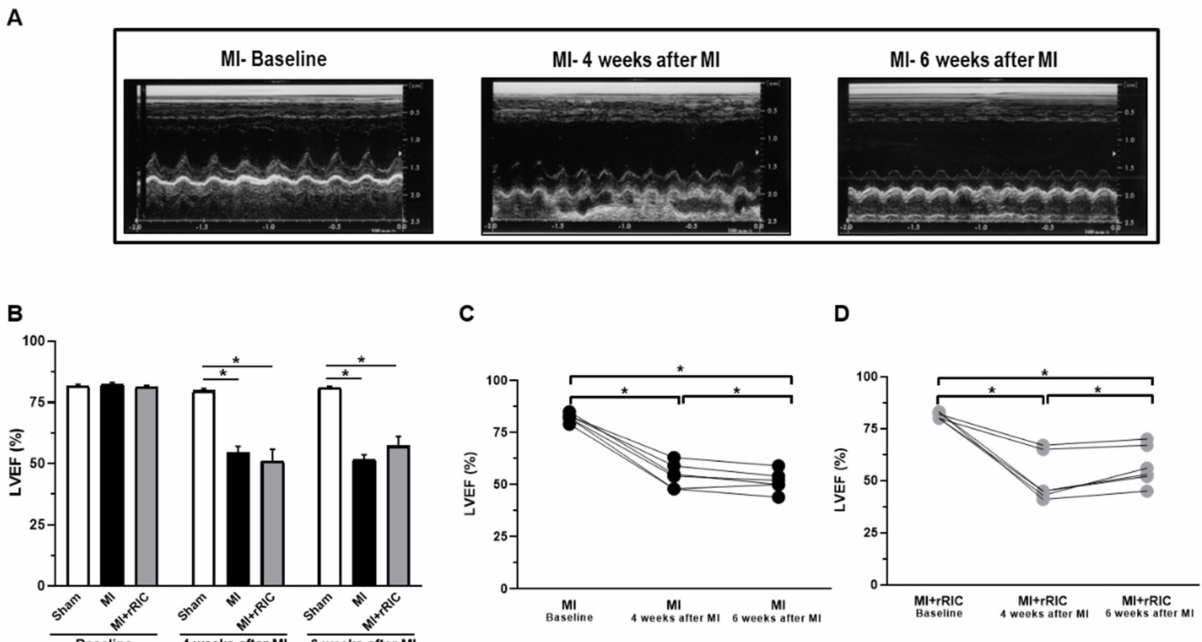
Figure 3. Changes in LV ejection fraction (LVEF) upon rRIC. Representative echocardiographic images during the deter- minations of LVEF ( A ). LVEF at baseline, 4 weeks and 6 weeks after MI induction ( B ). LVEF of individual rats in the MI group ( C ) and in the MI + rRIC group ( D ) at baseline, 4 and 6 weeks after MI induction. Values are given as mean ± SEM; n = 4–6 animals/group. * p <